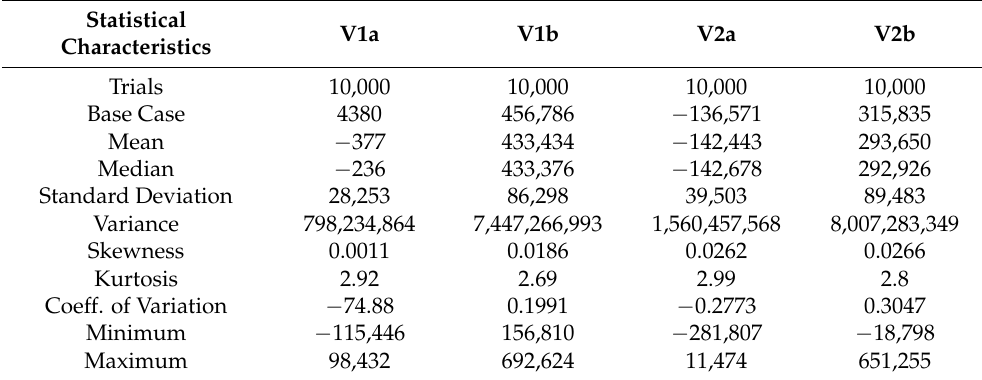
Table 8. Selected statistical characteristics of NPV versions of investment